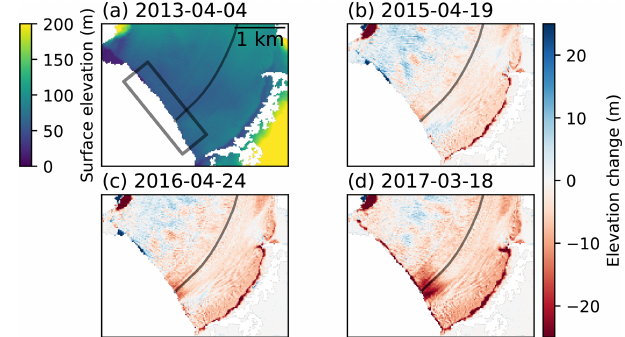
Figure 4. Elevation distribution in April 2013 (a) and elevation change from April 2015 to March 2017 (b–d) , using ArcticDEM. Colours in (b–d) show the total elevation change relative to April 2013 (negative, red, means lowering). The manually traced location of the moraine (Fig. 1a) is indicated by a transparent black line in all panels, and the location of cropped ortho-images in Fig. 3 is shown by a black rectangle in (a) .